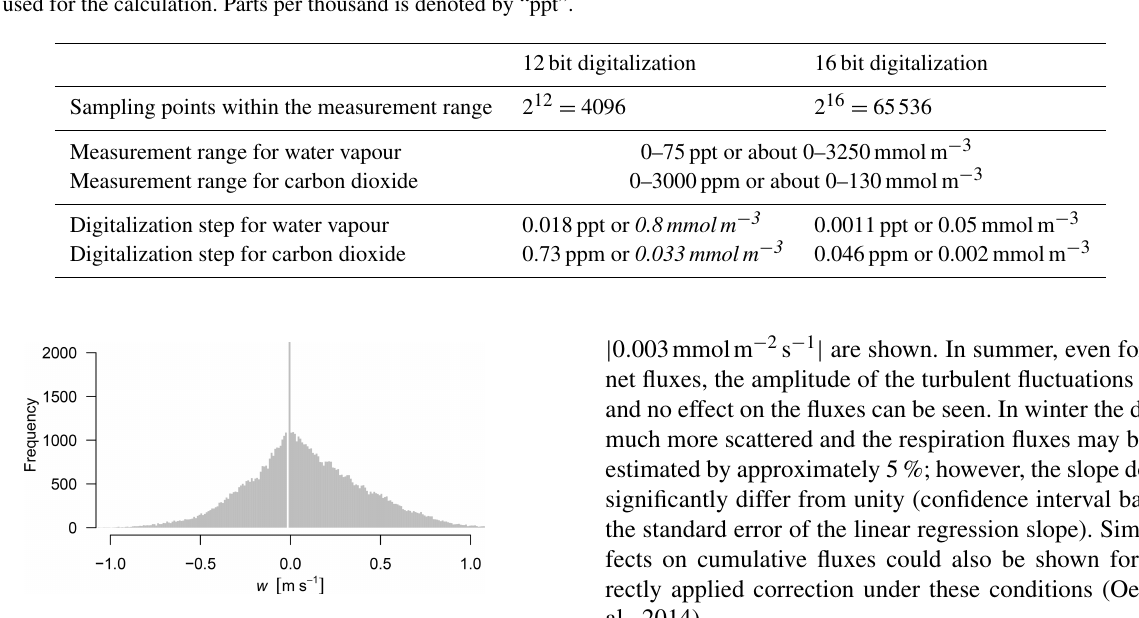
Figure 3. Probability density plot of the vertical wind velocity for 1h (summer at noon) with the manipulated instrumental error of the R2 sonic